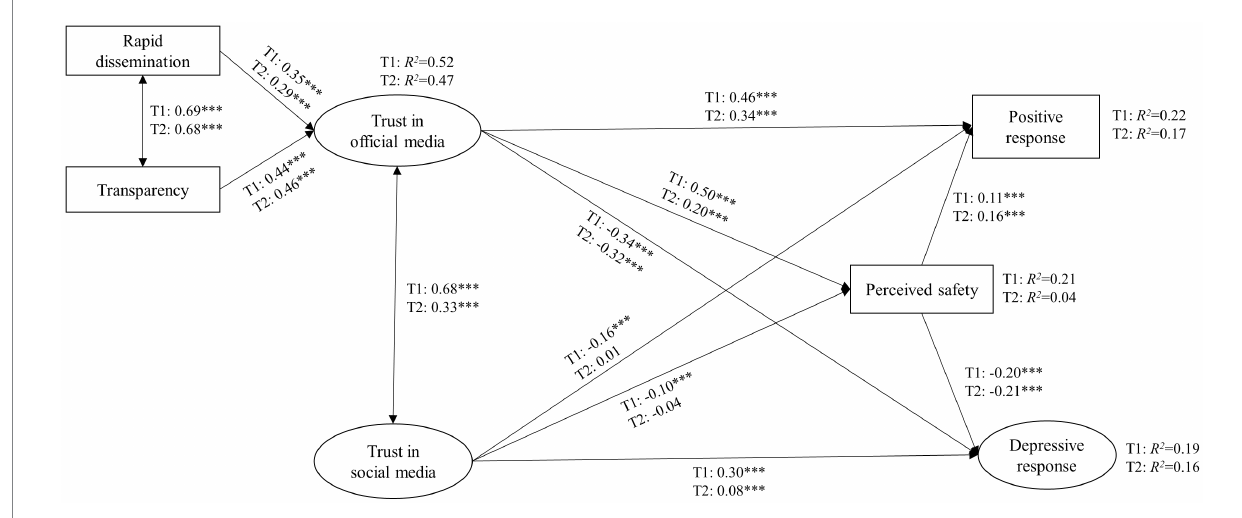
FIGURE 2 The relationship among information dissemination, trust in media sources, perceived safety, and emotional responses over